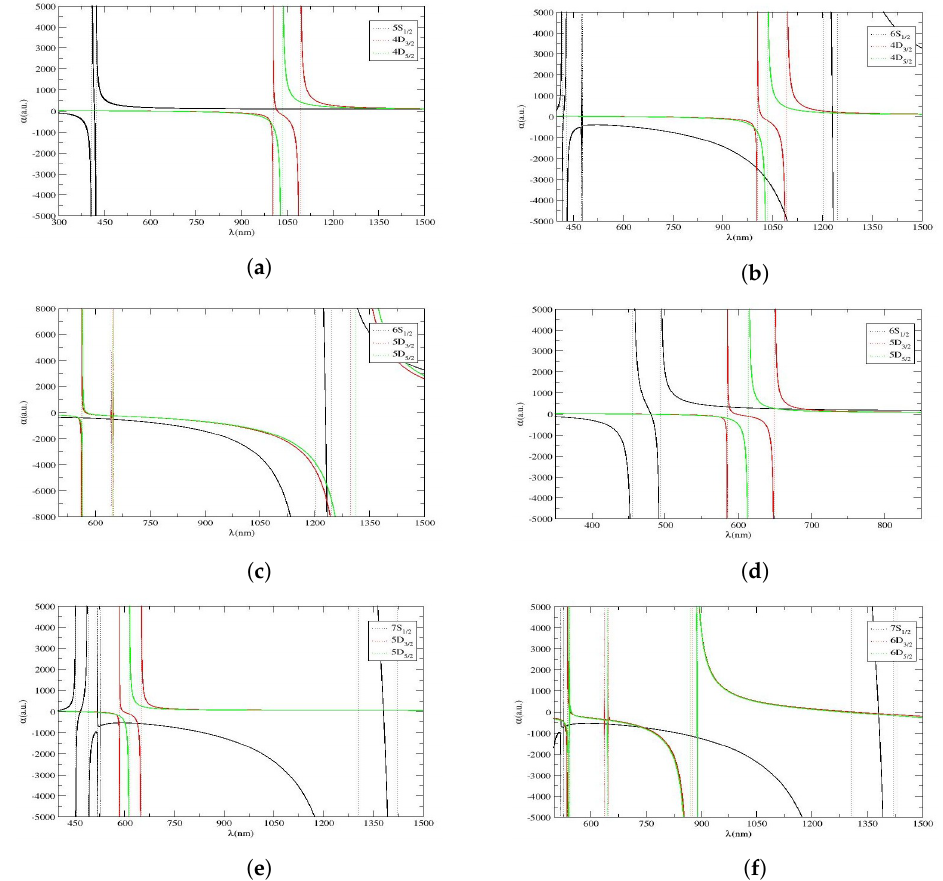
Figure 3. α v/s λ plots for various transitions in Sr + and Ba + ions. ( a ) α v/s λ plot for 5 S 1/2 and 4 D 3/2,5/2 states of Sr + ion. ( b ) α v/s λ plot for 6 S 1/2 − 4 D 3/2,5/2 transition in Sr + ion. ( c ) α v/s λ plot for 6 S 1/2 − 5 D 3/2,5/2 transition in Sr + ion. ( d ) α v/s λ plot for 6 S 1/2 − 5 D 3/2,5/2 transition in Ba + ion. ( e ) α v/s λ plot for 7 S 1/2 − 5 D 3/2,5/2 transition in Ba + ion. ( f ) α v/s λ plot for 7 S 1/2 − 6 D 3/2,5/2 transition in Ba +